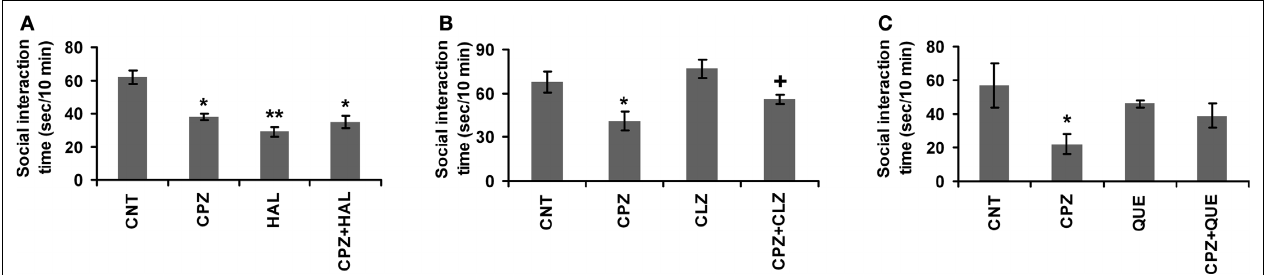
FIGURE 3 | Effects of antipsychotics on the CPZ-induced defi cits in the social interaction. Control and experimentally treated C57BL/6 mice were subjected to social interaction test on the same day (28th day after CPZ-exposure). (A) The data